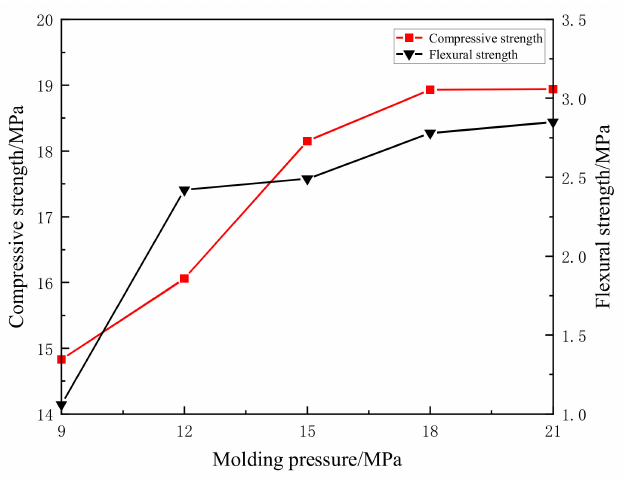
Figure 5. Compressive and flexural properties of aluminum dross non-fired bricks under different forming